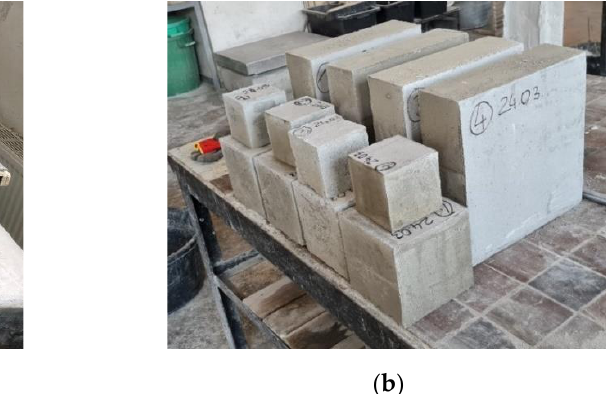
Figure 4. ( a ) The produced protein-based foam and ( b ) the structure of the foam with a density of 70 kg/m 3 .